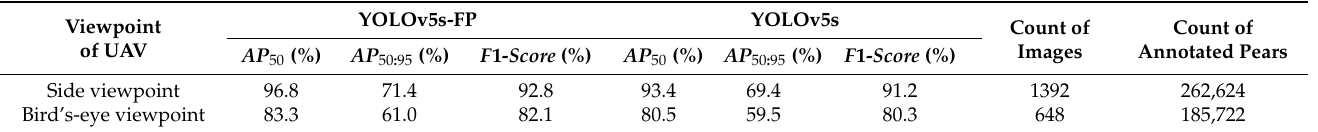
Table 7. Detection accuracy of two networks in different viewpoints of the